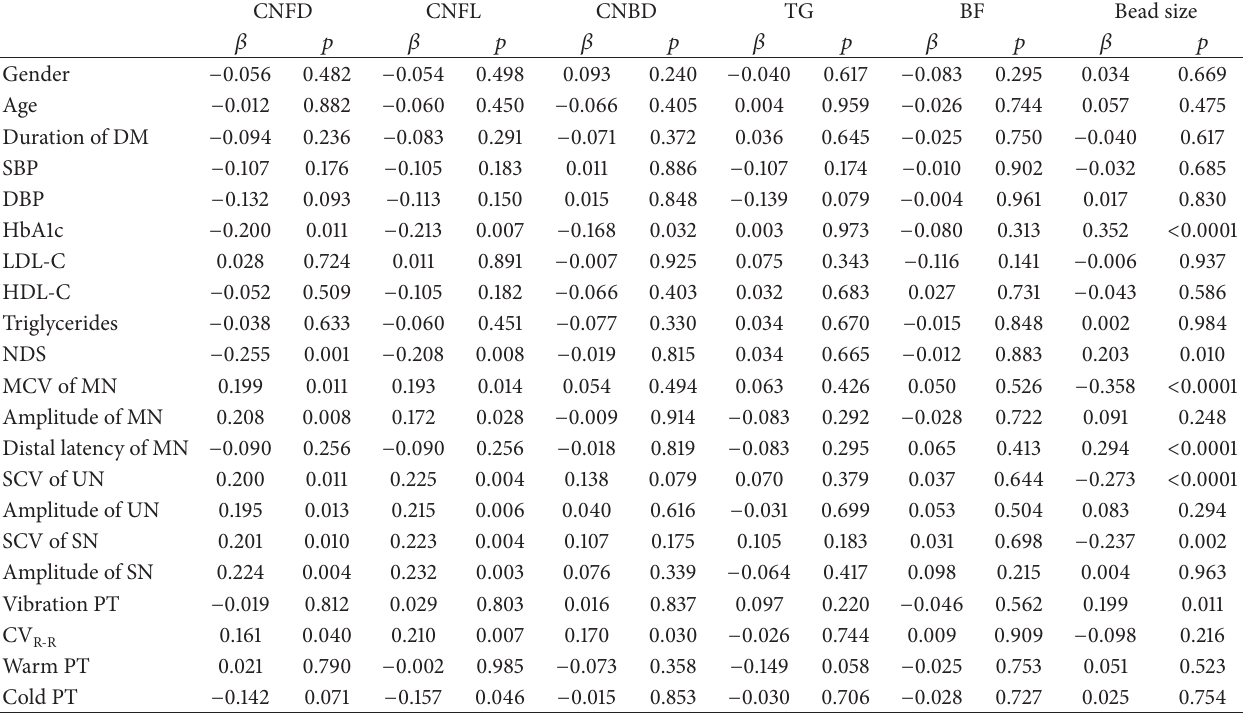
Table 4: Relationship between the various measures of corneal nerve fibers and clinical and neurophysiological parameters in patients with type 2